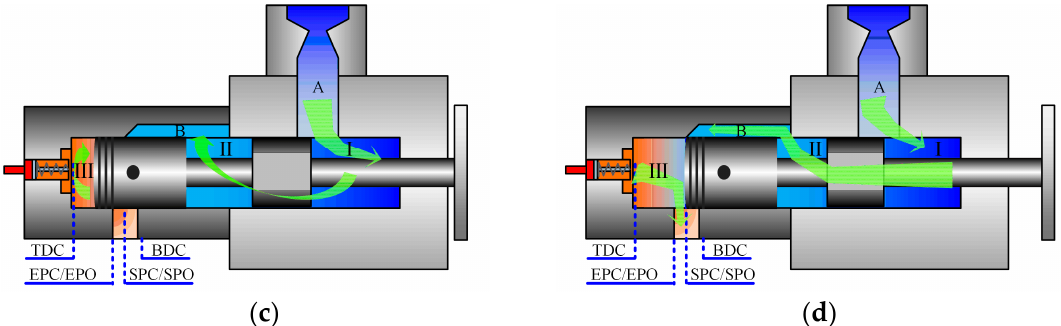
Figure 2. Working principle of the MFPG prototype. ( a ) Scavenging stroke; ( b ) Compression stroke; ( c ) Expansion stroke; ( d ) Exhaust stroke. The green arrows display the air flow during the four strokes.